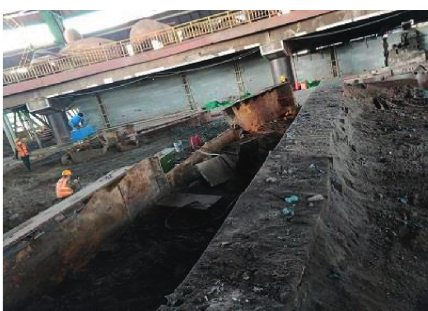
Figure 7: The slag outlet of a blast